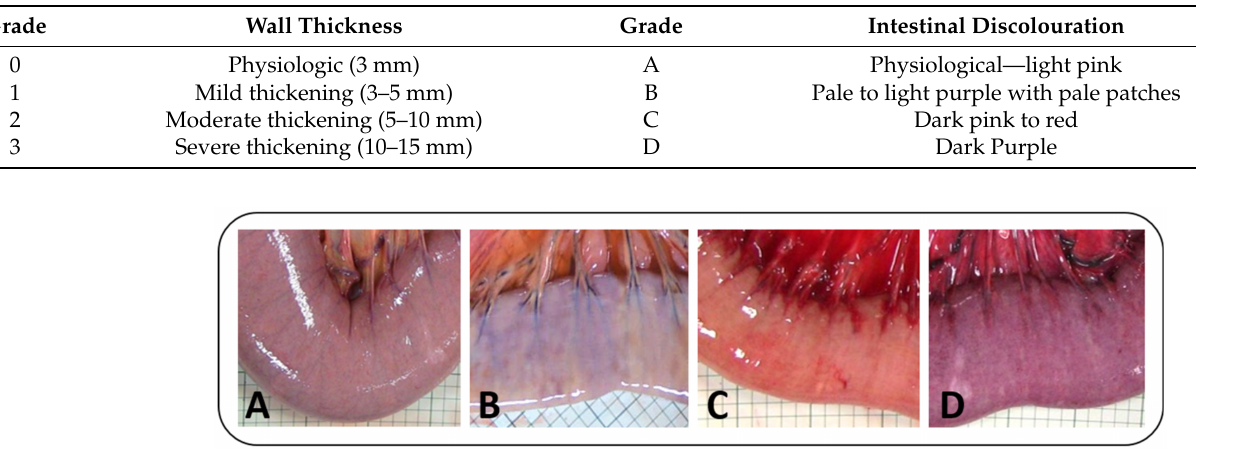
Figure 2. Exemplary images of different grades of intestinal discolouration following ischaemia and reperfusion.